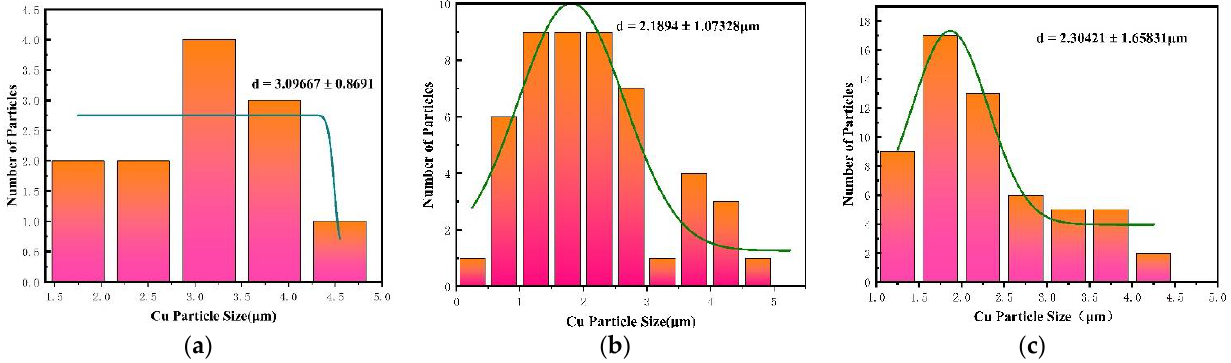
Figure 10. SEM image statistics of Cu particle size in PTFE/Cu materials with different density at 10μm scale : ( a ) PTFE/Cu-1; ( b ) PTFE/Cu-2; ( c ) PTFE/Cu-3.